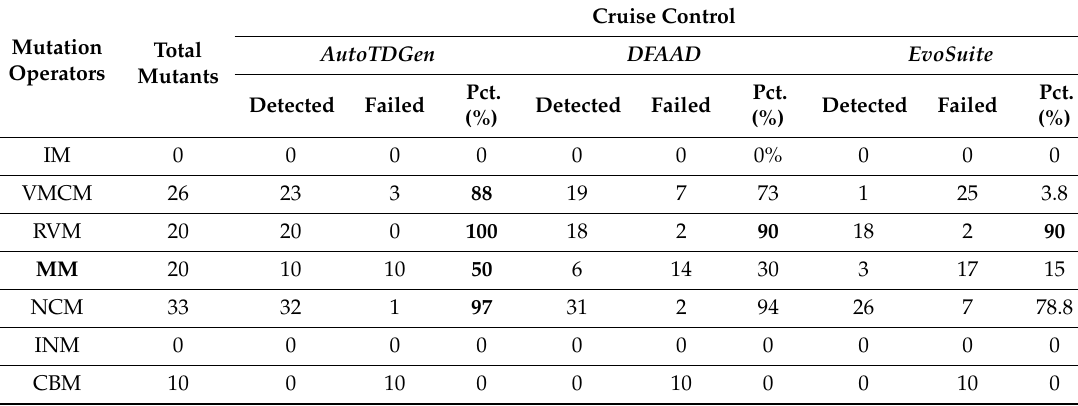
Table 5. Comparison results for the types of mutations covered in Cruise